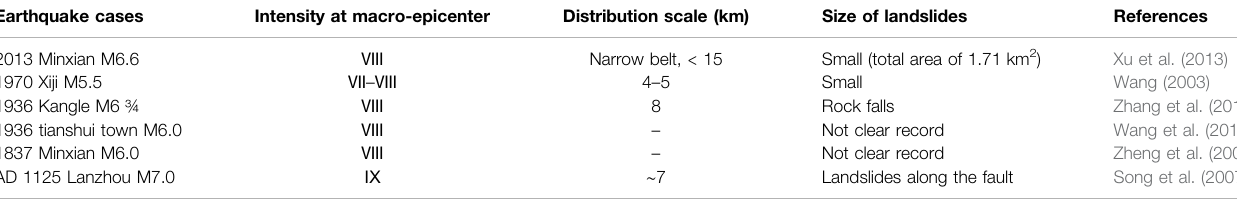
TABLE 2 | Interpretation and cataloging results of landslides triggered by earthquakes of approximately M6. Earthquake cases